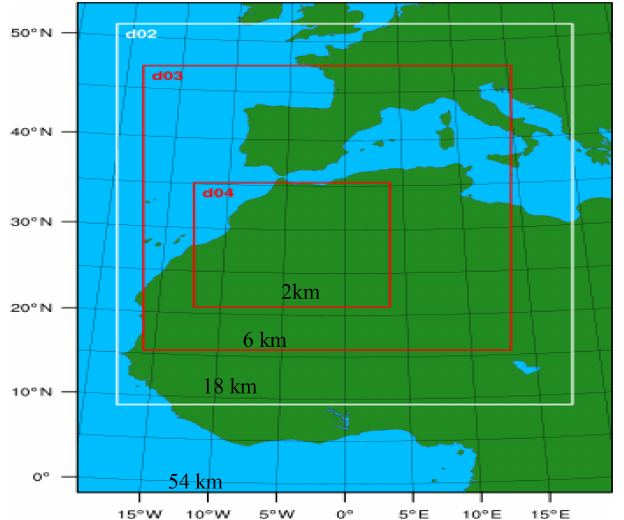
Figure 3. WRF domain configuration for the Harmattan dust storm case in Fig. 2 (Pokharel, 2016). The do1, do2, do3, and do4 repre- sent domains of 54, 18, 6, and 2km resolutions,